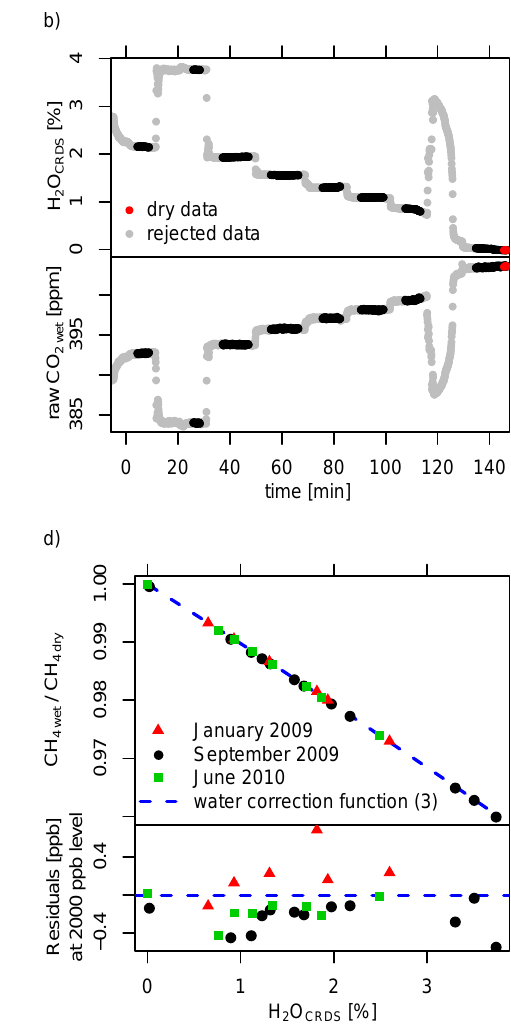
Fig. 3. Experiments at various water vapor levels: (a) setup; (b) H 2 O and CO 2 time series of an experiment in September 2009; correction function derived from all experiments for (c) CO 2 and (d) CH 4